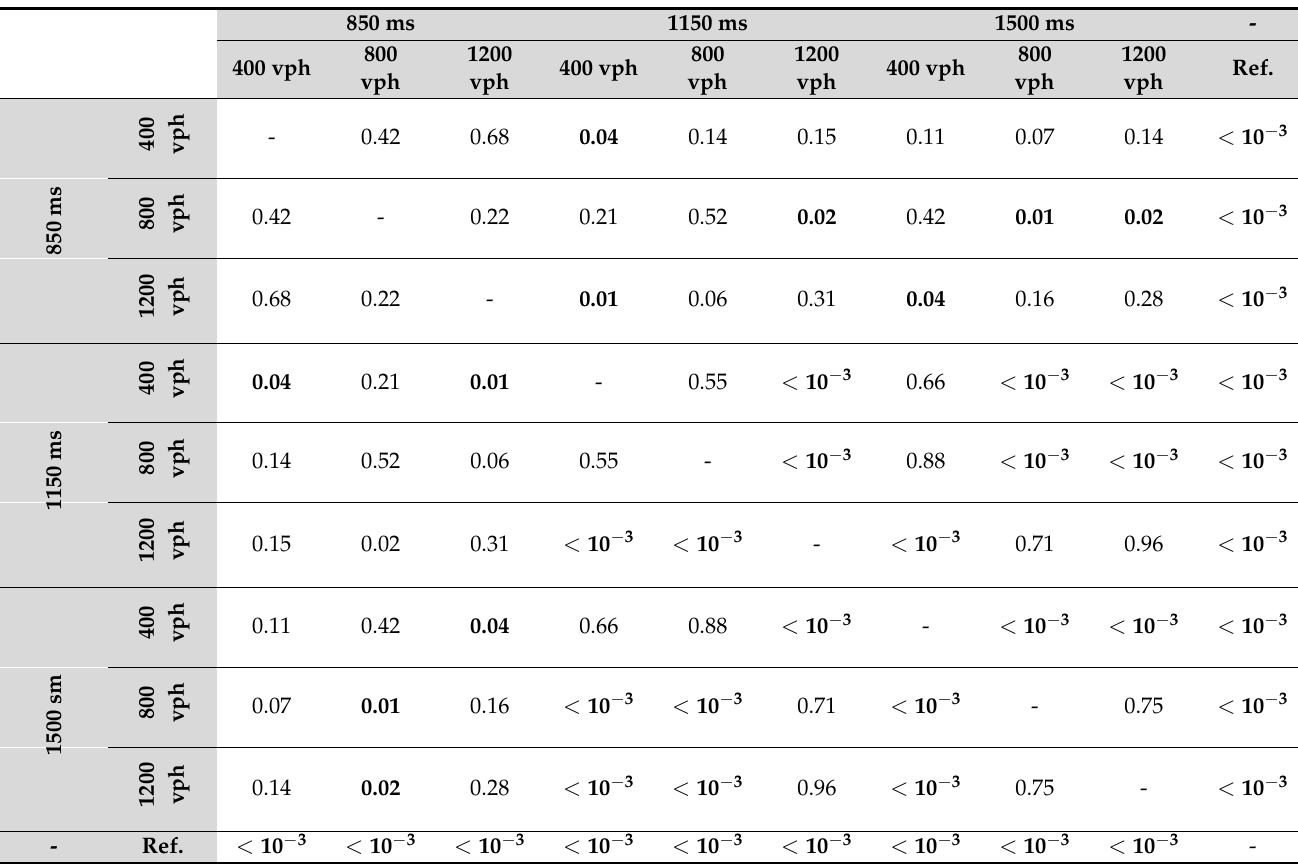
Table 1. Results of Dunn post hoc test carried out for acquired values of minimal distance increase after turning on the traffic management system.